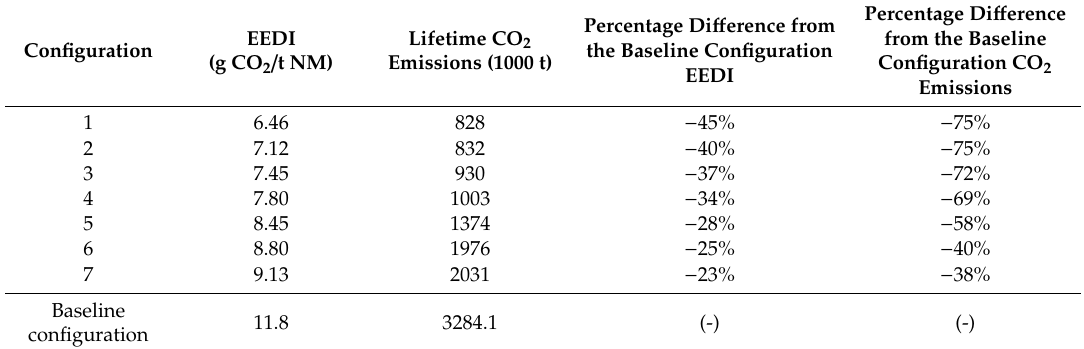
Table 15. Calculated EEDI values and lifetime CO 2 emissions for the cruise ship power plant